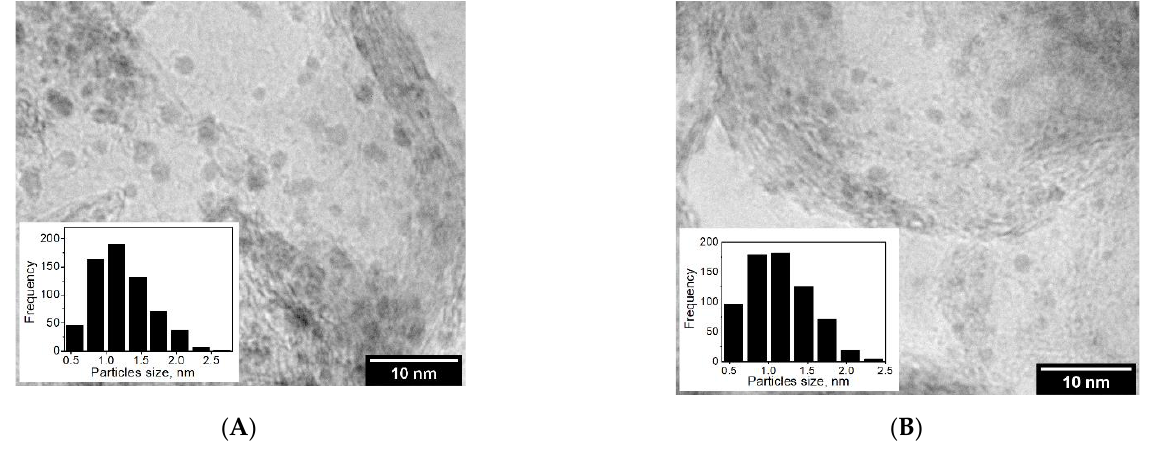
Table 2. The results of RCF of spruce wood at 225 ◦ C for 3 h over different Ru catalysts. Product Yield, wt% Solid Product Composition, Catalyst